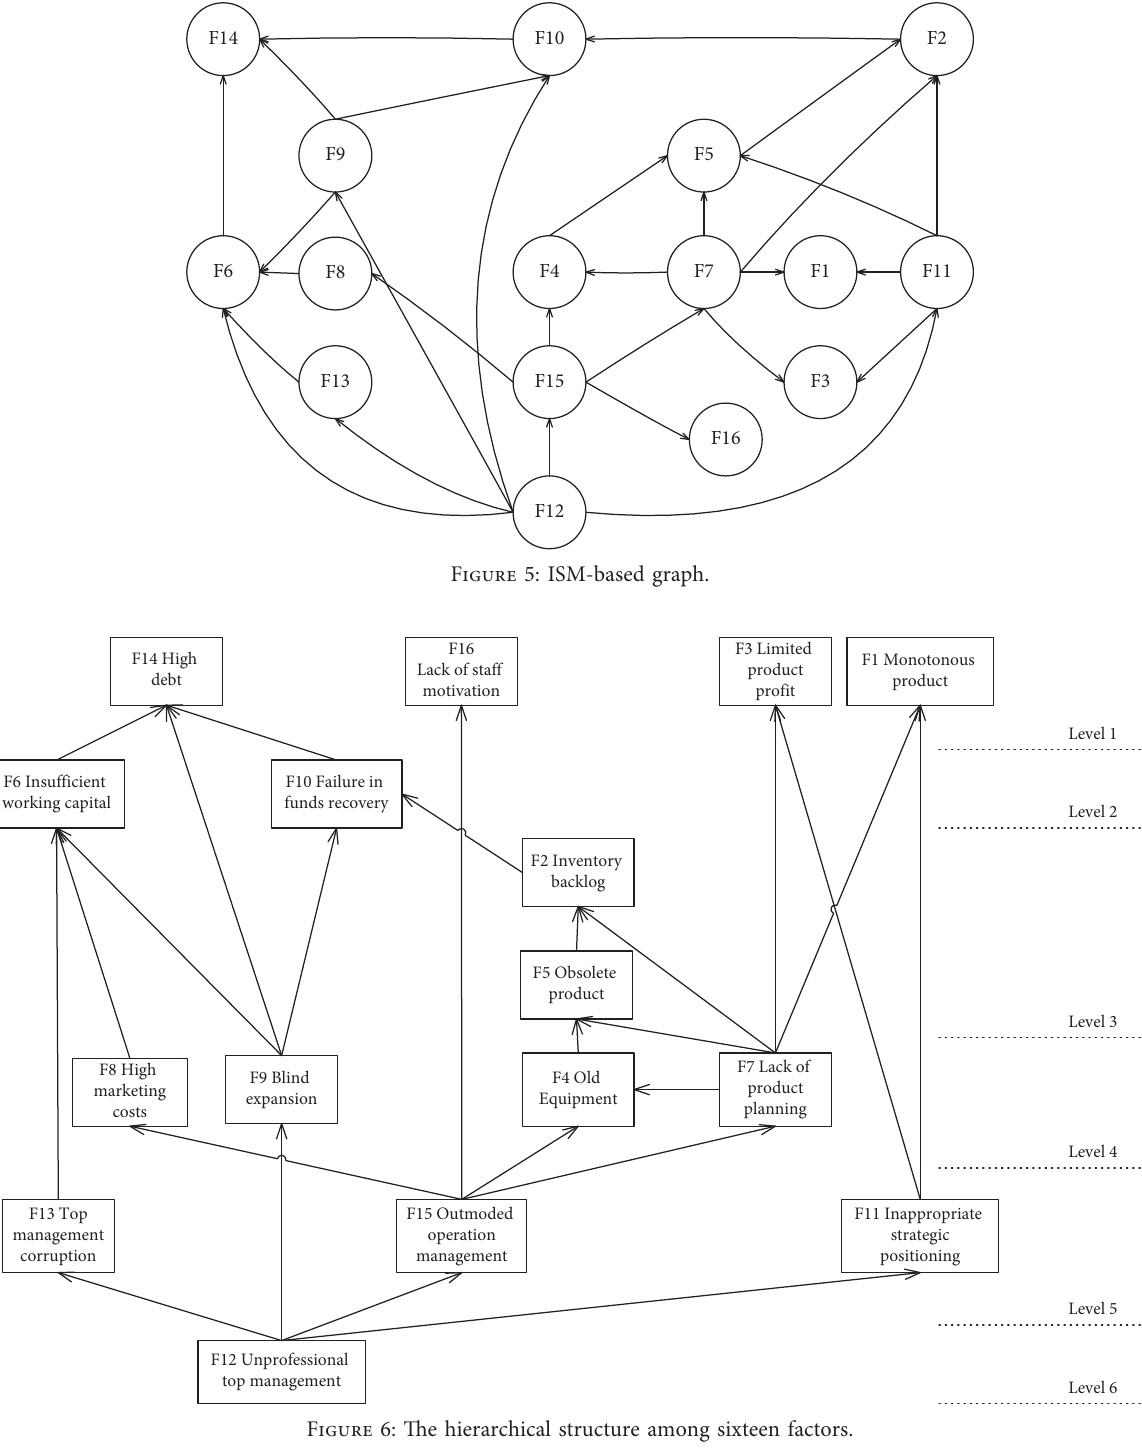
Figure 6: The hierarchical structure among sixteen factors.